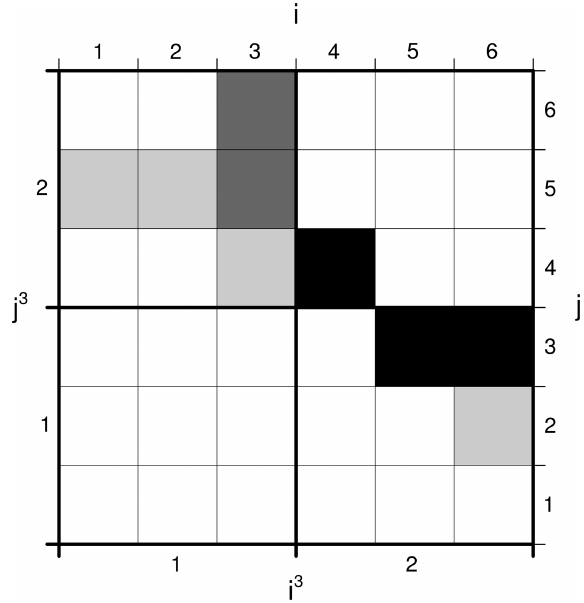
Figure 2. Schematic illustration for the computation of the fractions skill score for gridded contour lines. Gridded lines representing the ice edge of the model product and the observational product are shown as light gray boxes and dark gray boxes, respectively. Grid cells in which the two lines overlap are black. The original grid is displayed by thin grid lines with x -axis indices at the top and y - axis indices to the right. Thick grid lines correspond to the grid of a neighbourhood with an extent of three grid cells ( n = 3), with x - and y -axis indices at the bottom and to the left, respectively. See the text for